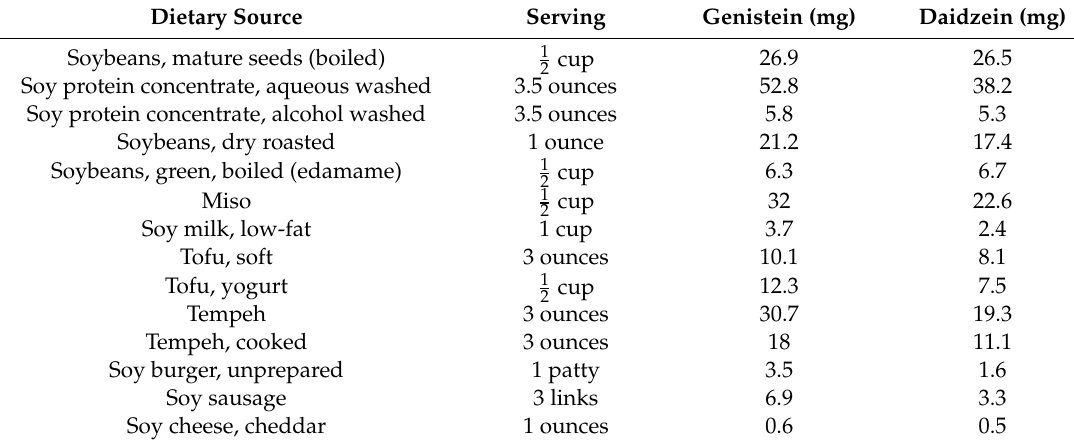
Table 2. Dietary sources of genistein and